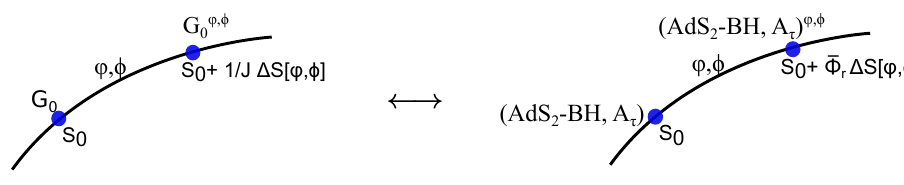
Figure 1 . The left panel represents the symmetry orbit of the classical large N solution for the fermion bilocal G 0 ( (cid:28) 1 ; (cid:28) 2 ), in the charged SYK model at the IR (cid:12)xed point J = 1 . The symmetry group, G is de(cid:12)ned as the group of transformations generated by Di(cid:11) and local U(1) transformations. The classical solution is invariant under H = SL(2 ; R ) (cid:2) U(1) global 2 G . The orbit represents the Nambu Goldstone modes belonging to the coset G = H . The right panel represents the symmetry orbit of AdS 2 black hole with gauge (cid:12)eld under large di(cid:11)eomorphism and large gauge transformation. Points of the orbit parameterize the same coset as on the left, and are represented by the asymptotically AdS 2 spacetimes with horizon (1.5) and A (cid:28) given by